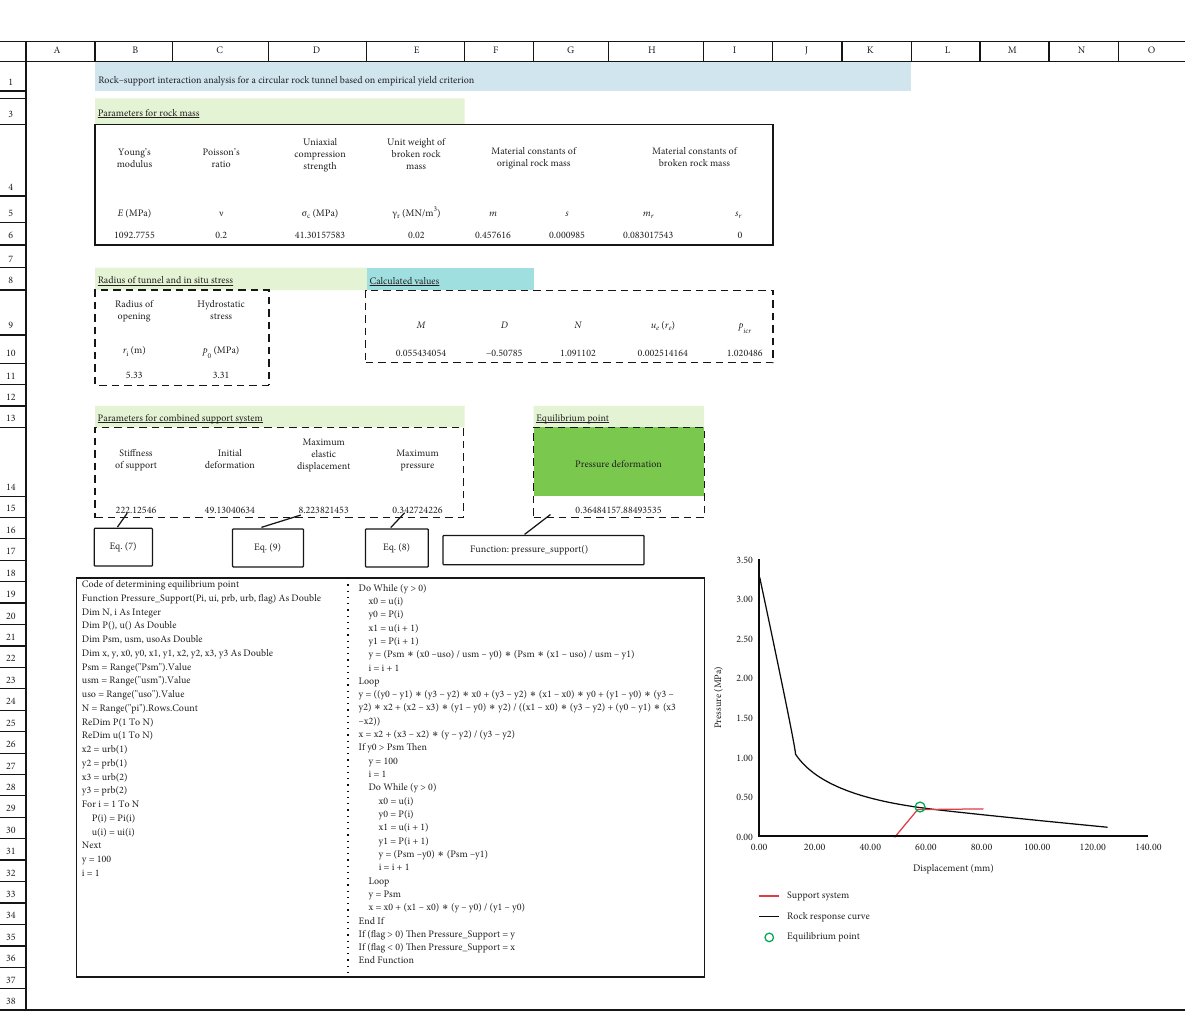
Figure 3: Rock-support interaction analysis based on an empirical yield